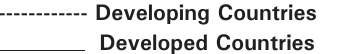
Figure 2. Neonatal Infection and morbidity and mor-